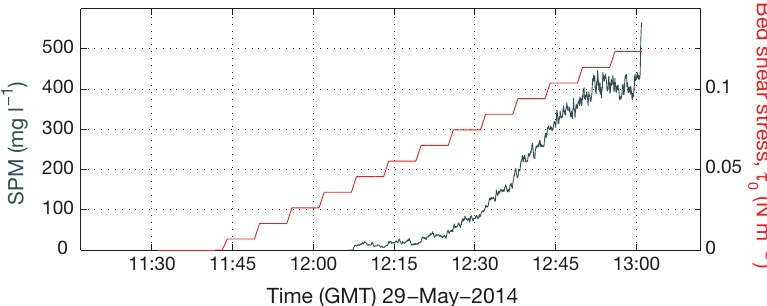
Fig. 6. Suspended particulate matter (SPM) concentration (black) and bed shear stress (red) time series for site 2_DFB2 (near field)